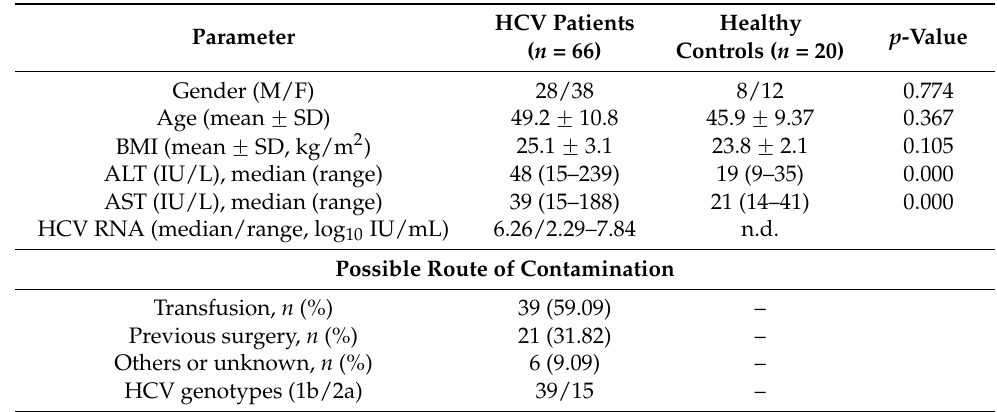
Table 1. Clinical characteristics of the study